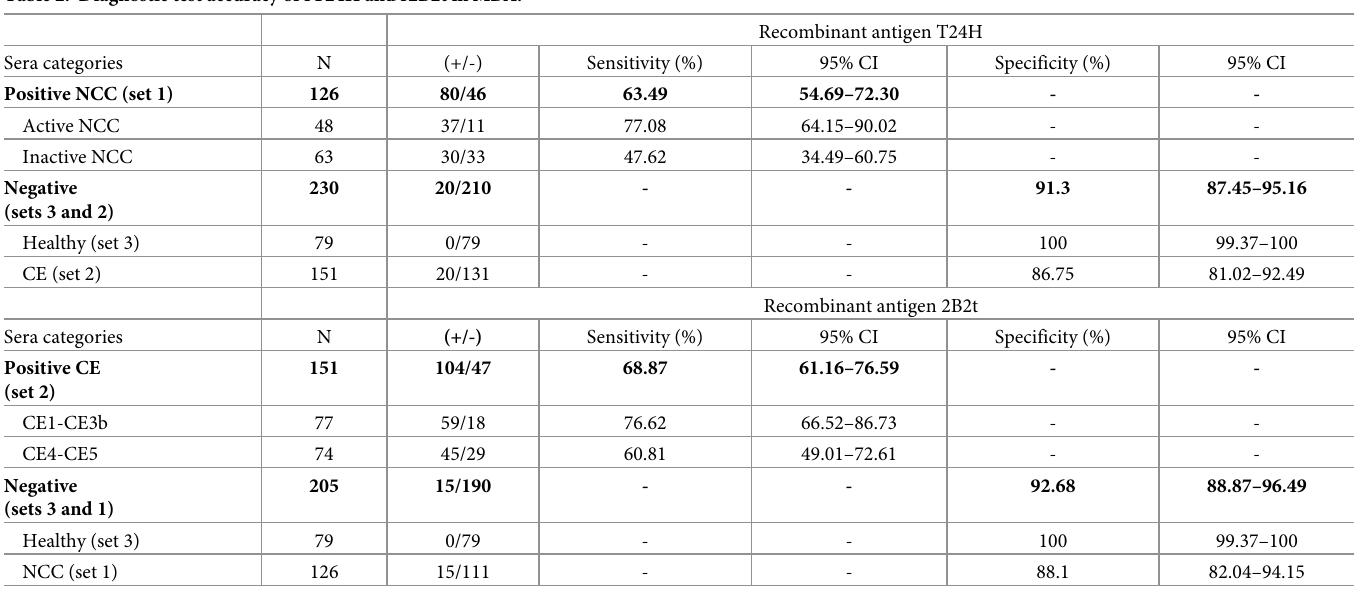
Table 2. Diagnostic test accuracy of rT24H and r2B2t in MBA.